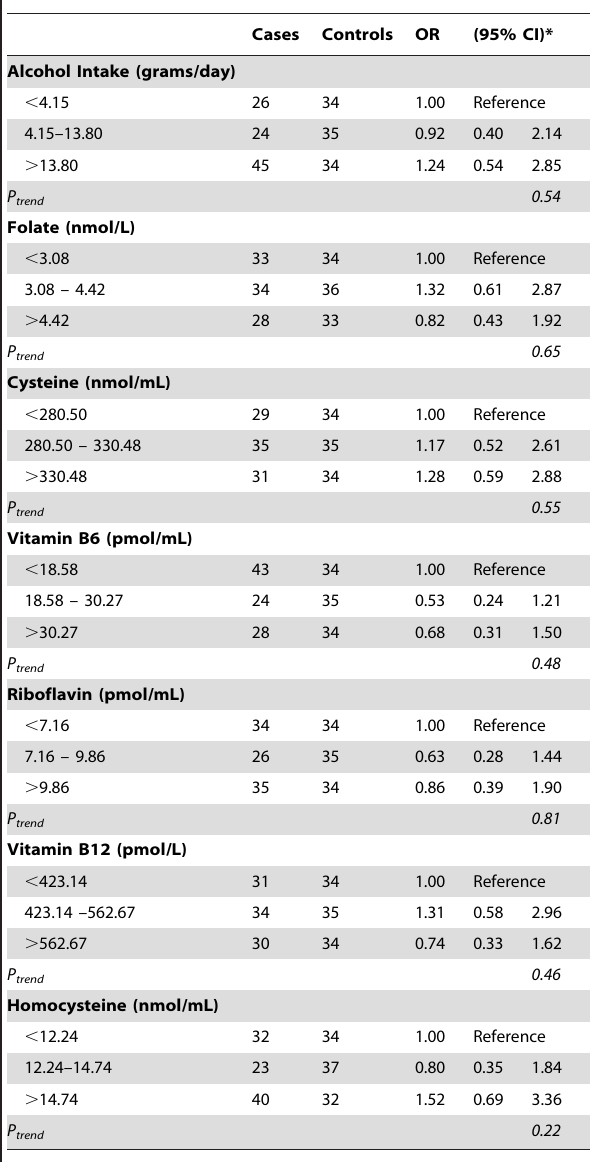
Table 3. Association between alcohol consumption and one- carbon metabolite serum levels and the risk of liver cancer incidence in the ATBC